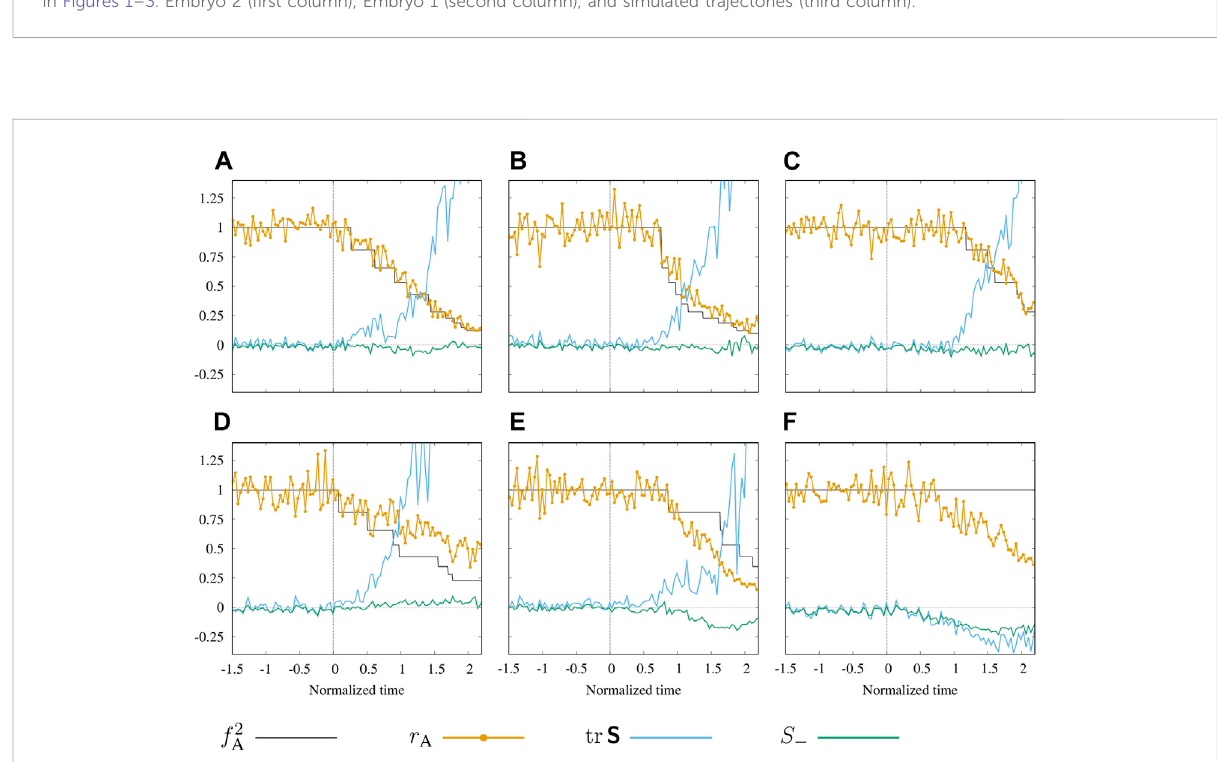
FIGURE 10 Mechanics of the cellular constriction process. (A – F) Time histories of the area reduction factor r A and the square of the anchor constriction factor f 2 A areshownalongwiththetracetr S andthesmallereigenvalue S − ofthenormalizedvirialstresstensorEq.4(aslabeled)forseveralcellsinthe simulated constricting system. Time normalization as de fi ned in Figure 6. Positive stress corresponds to tension and negative stress to compression. Cells respond to the stresses both by passive deformation and by active ratcheted constrictions represented by a stepwise decrease of f 2 A